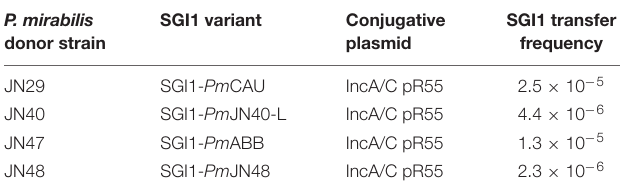
TABLE 2 | Conjugative transfer frequency of P. mirabilis SGI1s.